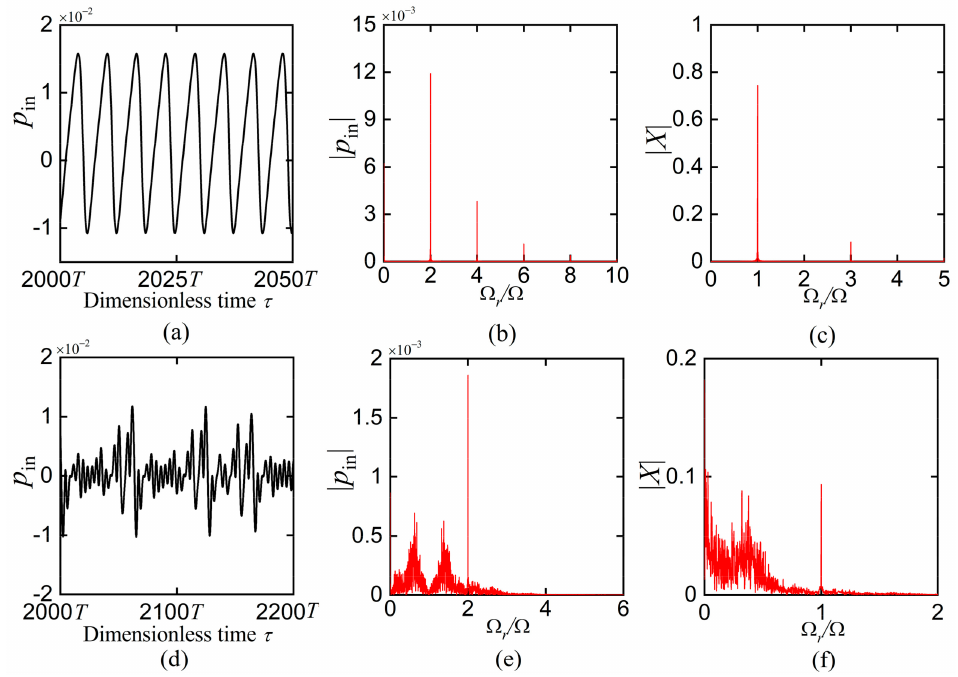
Figure 10. Instantaneous input power. Parameters α = − 0.55, β = 2, ξ = 0.02, F 0 = 0.05, and ( a – c ) Ω = 0.5, period–1 motion; ( d – f ), Ω = 0.8, chaotic motion. ( a , d ) are for transient input power; ( b , e ) are the frequency components in p in ; ( c , f ) show the frequency components in